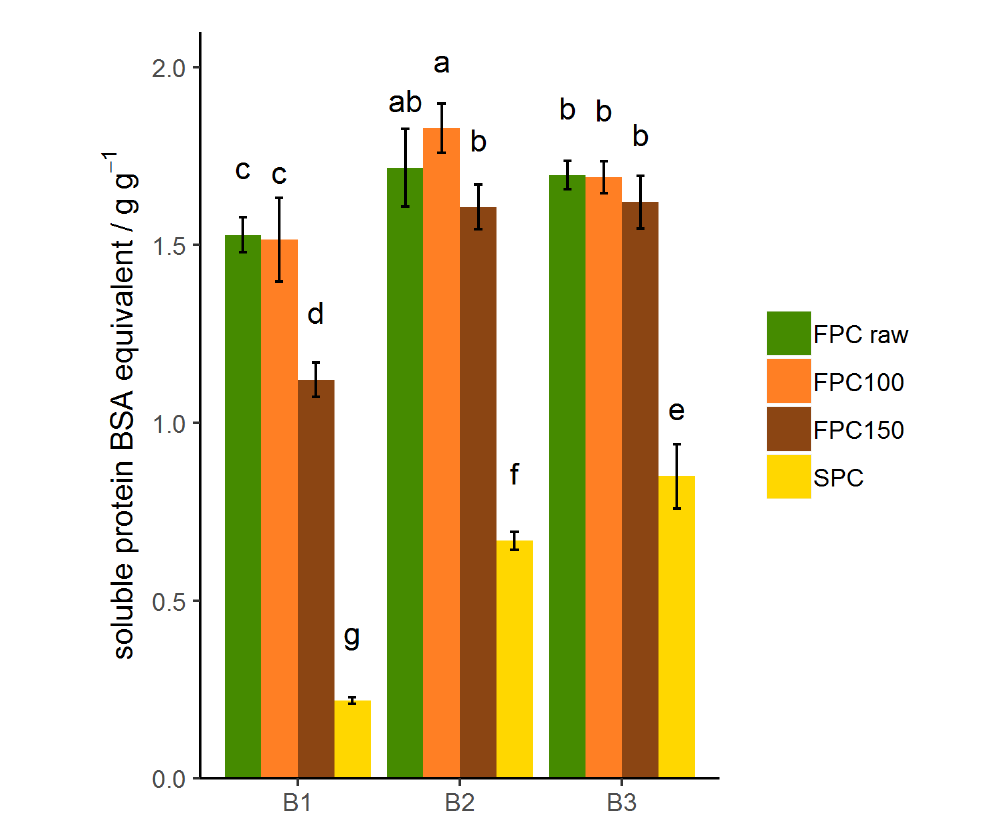
Figure 6. Solubility of protein dry-heated and non-dry-heated FPC as well as commercial SPC after disrupting electrostatic interactions (B1), noncovalent interactions (hydrophobic and electrostatic interactions and hydrogen bonds) (B2), and covalent and noncovalent interactions (B3). n = 9. Solubility is expressed as BSA equivalent per gram FPC or SPC. Significant differences are indicated by different lowercase characters ( p <0.01). Samples dry-heated at 150 ◦ C showed a significant difference in solubility in B1 compared to non-dry-heated FPC. Solubility of dry-heated and non-dry-heated FPC increased from B1 to B2, but not from B2 to B3. Solubility of SPC increased from B1 over B2 to